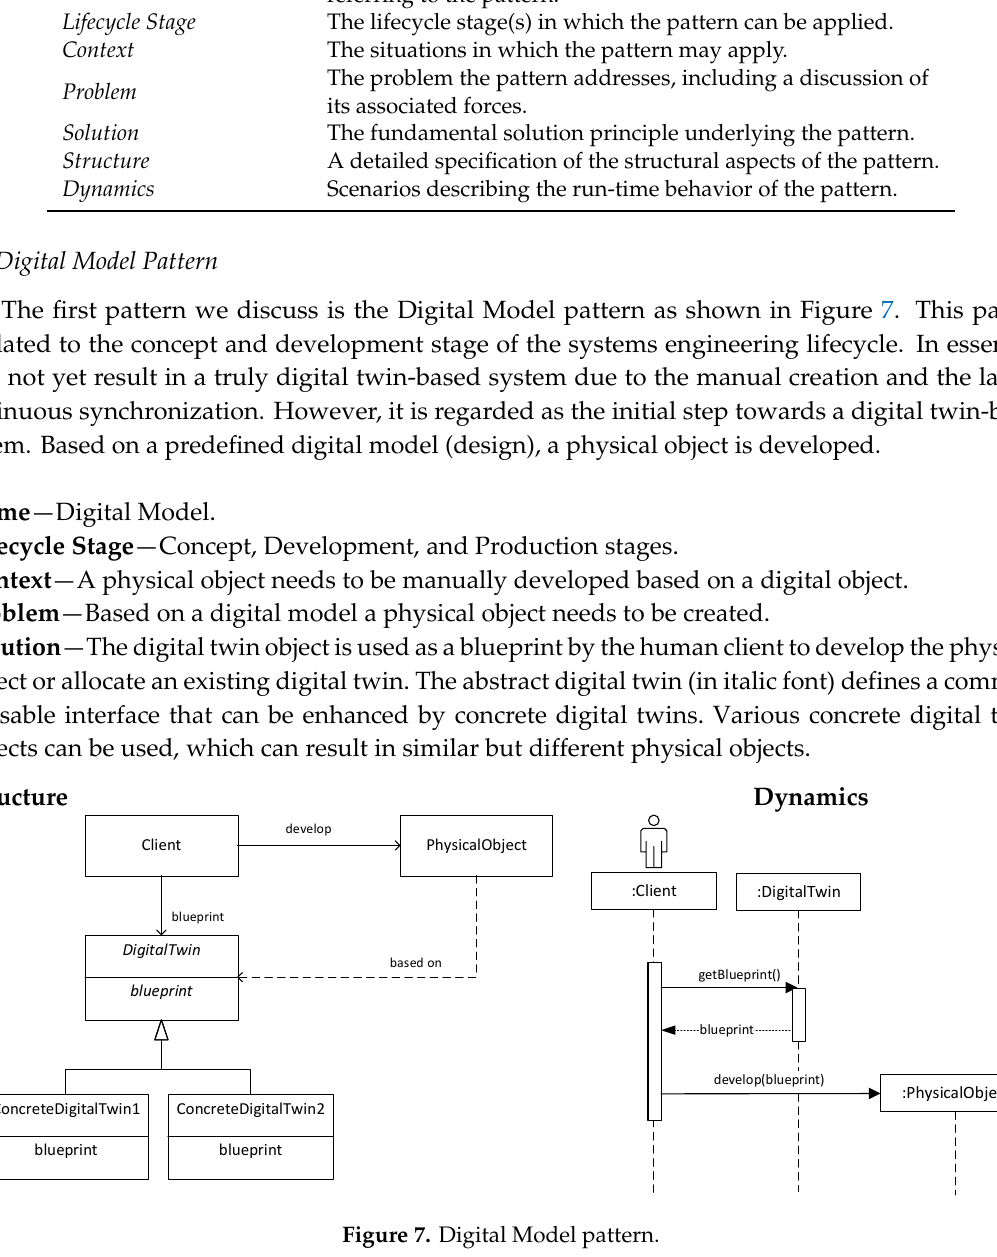
Figure 7. Digital Model pattern.